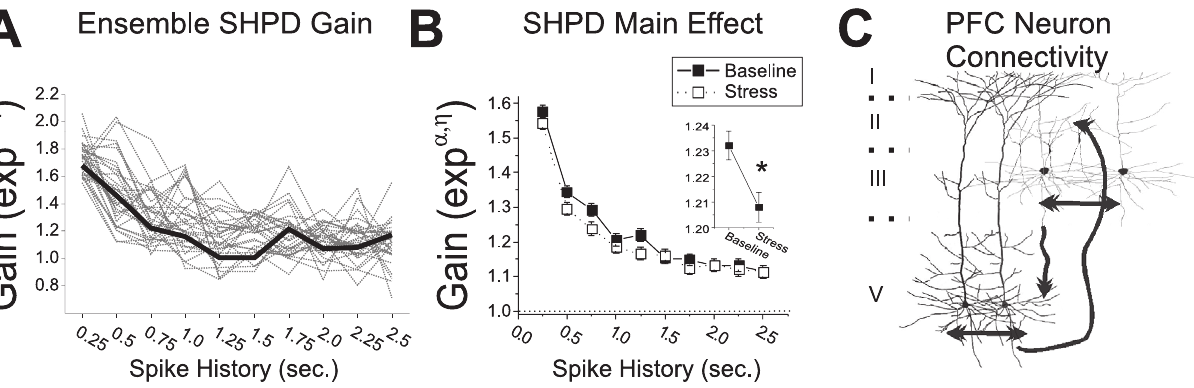
Figure 4. Stress-related changes in pl PFC neuron spike-history predicted discharge (SHPD) throughout baseline or acute stress conditions. A ) Spiking gain (rate-ratio exp a , g ) measures of the contribution of spike history at different points back in time for a small (n=50) ensemble of neurons. The SHPD gain of one exemplar neuron is highlighted. B ) SHPD gain at different points back in time decay exponentially under baseline and stress conditions (Model 1a). Described in the main text, stress produced an overall reduction in SHPD gains (inset; *p , 0.005), but did not significantly alter the decay of gains at any spike history time bin. C ) Schematic of recurrent pathways within the PFC of connectivity within layers II/III or V as well as connectivity between II/III and V represents one putative mechanism supporting SHPD. Adopted from: